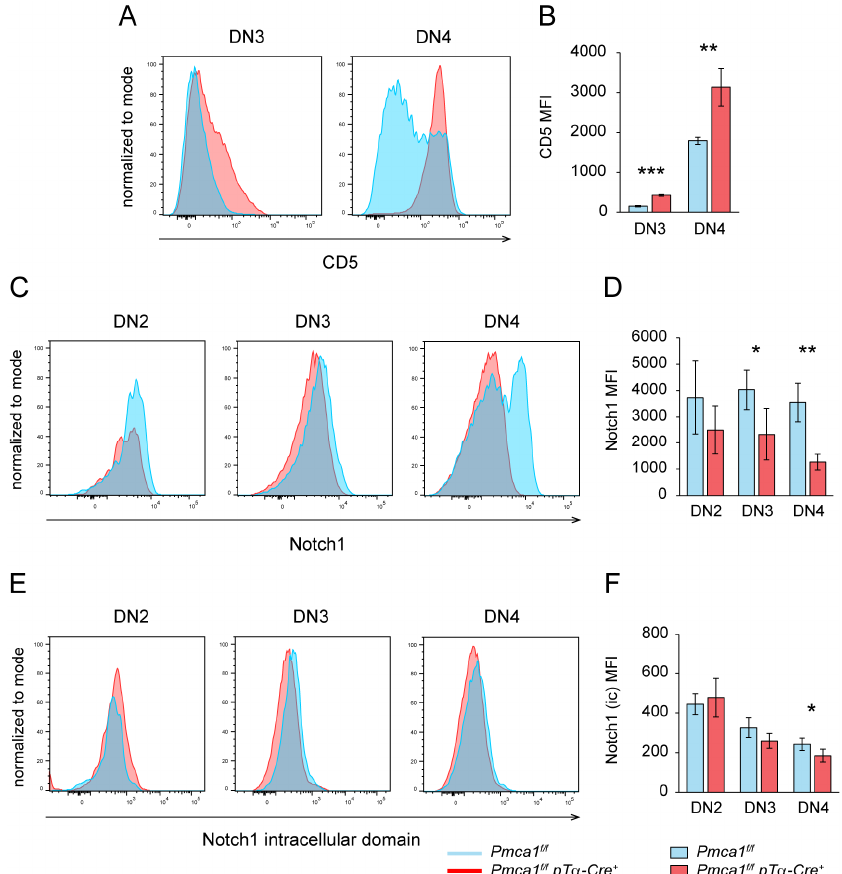
Figure 5. DN thymocytes of Pmca1 f/f pT α -Cre + mice show pre-mature signaling. ( A , B ) FACS analysis of the CD5 surface expression on DN thymocytes of Pmca1 f/f and Pmca1 f/f pT α -Cre + mice shown as representative histograms ( A ) of the CD5 fluorescence intensity on DN3 and DN4 thymocytes, respectively, and quantified ( B ) as the mean MFI ± SD combined from 3 experiments. ( C , D ) FACS analysis of the Notch1 surface expression in DN thymocytes of Pmca1 f/f and Pmca1 f/f pT α -Cre + mice. Representative histograms ( C ) of Notch1 are shown for DN2, DN3 and DN4 thymocytes, respectively. The bar graph ( D ) shows the mean MFI ± SD of Notch1 surface staining in these populations combined from 3 experiments. ( E , F ) Intracellular FACS analysis of the cleaved cytosolic Notch1 domain in DN thymocytes of Pmca1 f/f and Pmca1 f/f pT α -Cre + mice. Histograms of the cleaved Notch1 fluorescence intensities are shown for DN2, DN3 and DN4 thymocytes, respectively ( E ). The bar graph ( F ) shows the mean MFI ± SD combined from 3 experiments. * p < 0.05, ** p < 0.01, *** p < 0.001, all by an unpaired two-tailed t